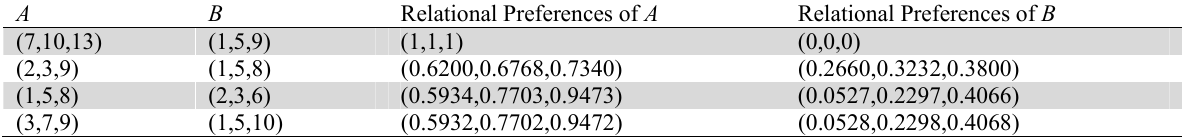
Relational preferences expressed by TFNs